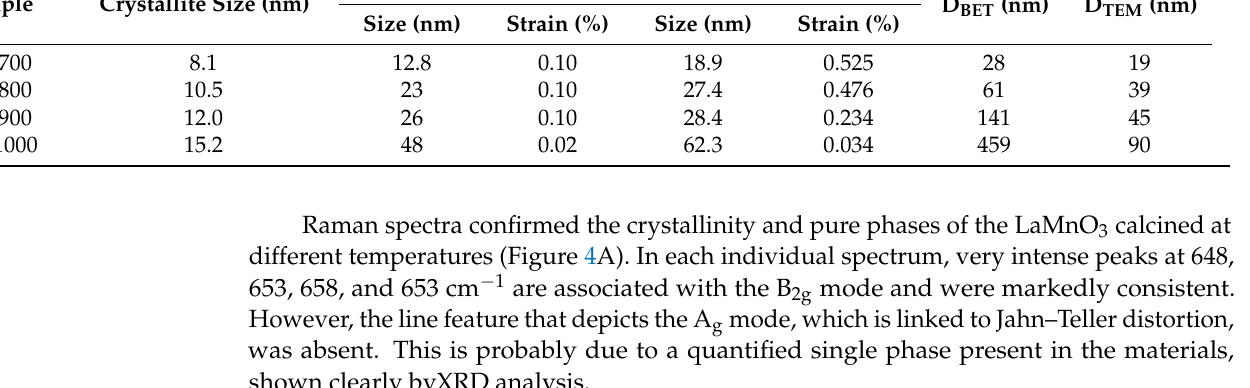
Table 2. Grain and particle size of LaMnO 3 samples.